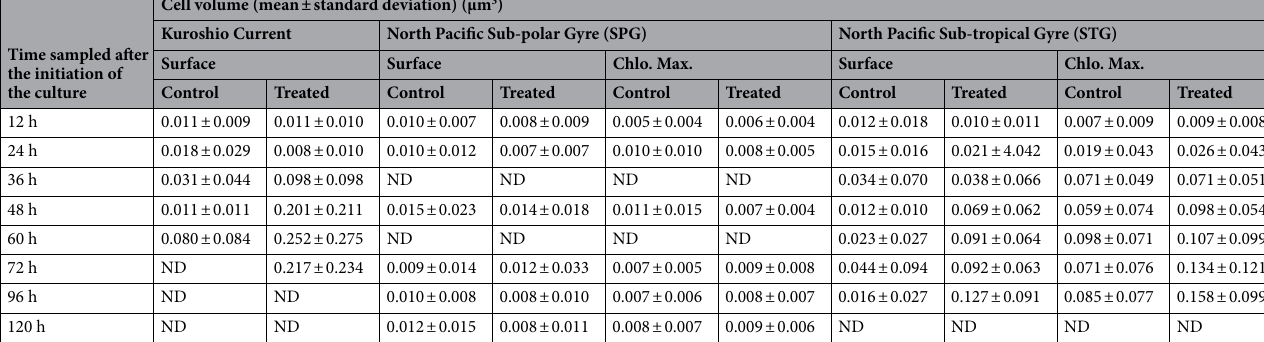
Table 3. Changes of cell volume (mean ± standard deviation) during the shipboard microcosm experiments with the water collected from the Kuroshio Current, North Pacific Sub-polar Gyre (SPG), and North Pacific Sub-tropical Gyre (STG) in the western North Pacific Ocean during the KH-14-2 cruise in May–June 2014. Chlo. Max. chlorophyll maximum.